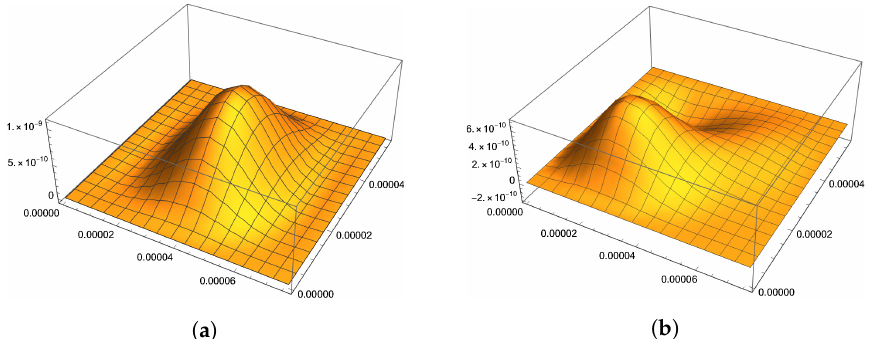
Figure 13. Recovery of loads when the SVD-based regularization is applied, with N Trunc = 12. ( a ) Recovery of f 1 with SVD-based regularization. N Trunc = 12. ( b ) Recovery of f 2 with SVD-based regularization. N Trunc =